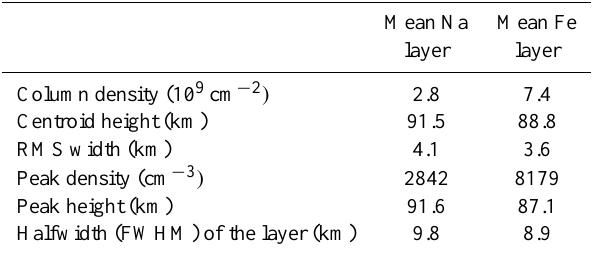
Fig. 3. Profiles of Na and Fe density scale heights (orange and blue solid lines) as calculated from Fig. 2. The profiles have been smoothed with a running mean over 1.2 km in altitude. For comparison, profiles of the atmospheric scale height (black solid line) and natural scale heights for Na (orange dotted line) and Fe (blue dotted line) atoms are also given. The Na scale height has a minimum (absolute value) of –0.42 km at the lowest point of the layer, while for Fe this value is –0.30 km. On the layer upper side, the Na scale height has a value of ~1.06 km at the highest point of the layer, while for Fe this value is ~0.82 km.